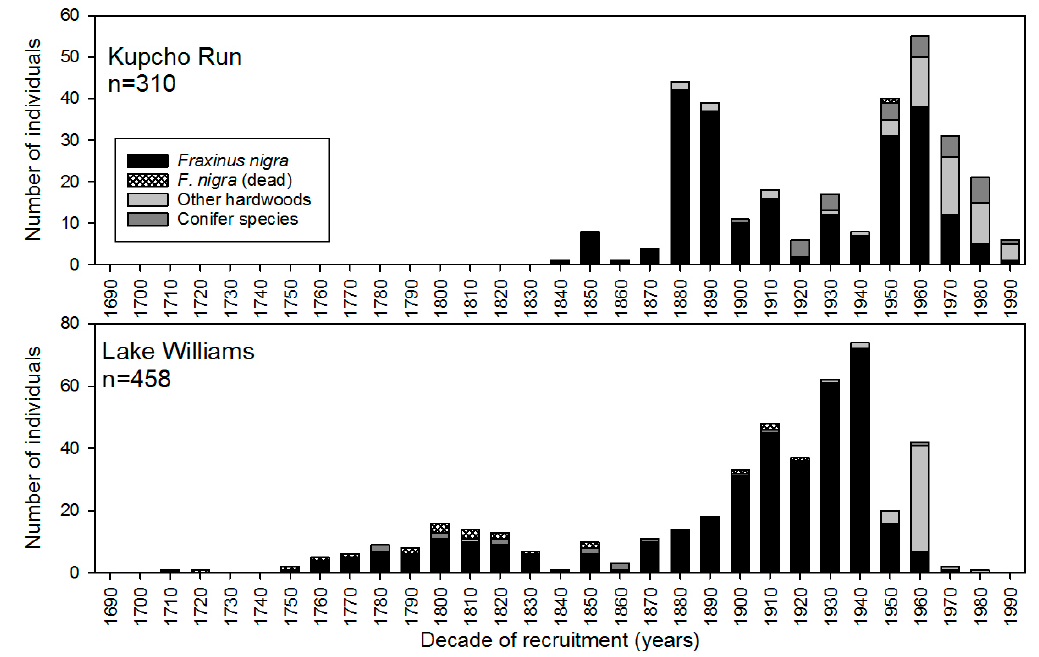
Figure 1. Age structure for two old-growth black ash forests in Minnesota. Sample size corresponds to number of cored individuals for which recruitment ages were obtainable, including several downed, dead black ash. The Kupcho Run site is classified as a “Very Wet Ash Forest (WFn64)”, whereas the Lake Williams site is classified as a “Wet Ash Forest (WFn55)” based on Aaseng et al. [25]. Other hardwood species are largely Ulmus americana L., Tilia americana L., Betula alleghaniensis Britt., Acer rubrum L., and Quercus macrocarpa Michx. Conifer species are Abies balsamea (L.) Mill., Picea glauca (Moench) Voss, and Thuja occidentalis L.